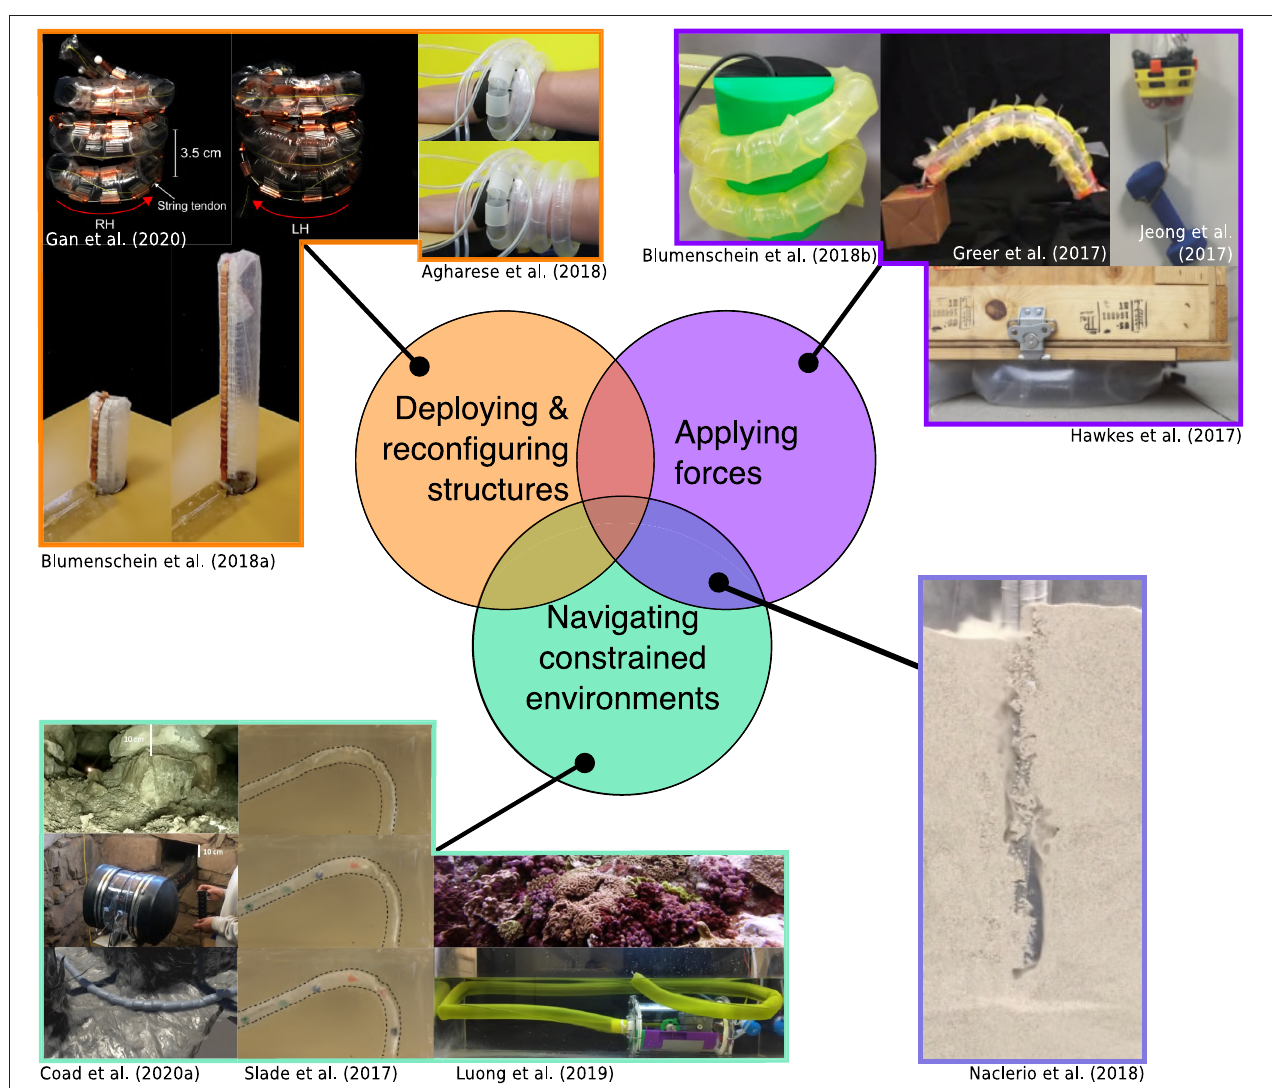
FIGURE 12 | Everting vine robot applications organized by the function of the robot in the application, including (top left) deploying and reconfiguring structures, (bottom left) navigating constrained environments without damaging the environment or the robot, and (top right) applying forces to the environment through squeezing, pushing, pulling, or expanding. (Bottom right) Some applications, such as burrowing, incorporate multiple functions. Modified from Hawkes et al. (2017). Reprinted with permission from AAAS. Modified from Blumenschein et al. (2018a) © IEEE 2018, Gan et al. (2020) © IEEE 2020, Agharese et al. (2018) © IEEE 2018, Blumenschein et al. (2018b) © IEEE 2018, Greer et al. (2017) © IEEE 2017, Jeong et al. (2020), Naclerio et al. (2018) © IEEE 2018, Coad et al. (2020a) © IEEE 2020, Slade et al. (2017) © IEEE 2017, and Luong et al. (2019) © IEEE